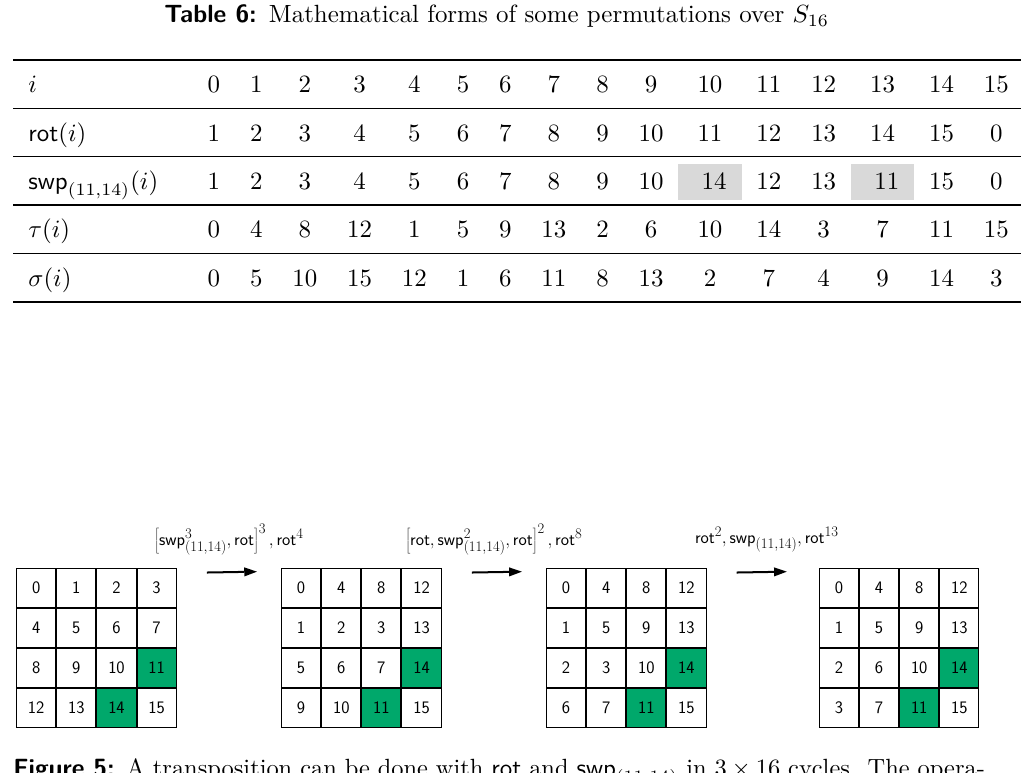
Table 6: Mathematical forms of some permutations over S 16